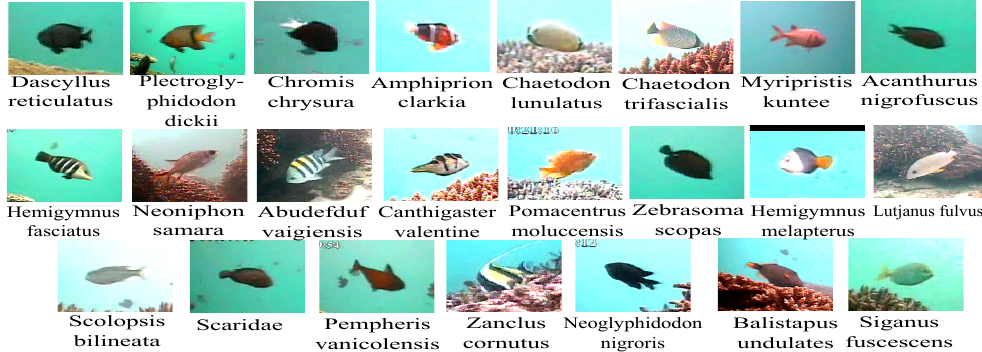
Figure 6. Sample images of 23 fish species in the FRGT